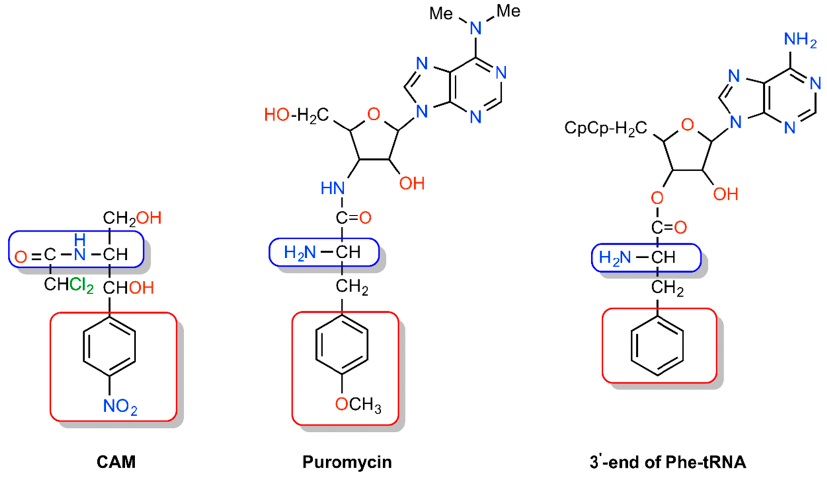
Figure 3. Structures of CAM, puromycin and Phe-tRNA Phe in an iso-structural orientation.